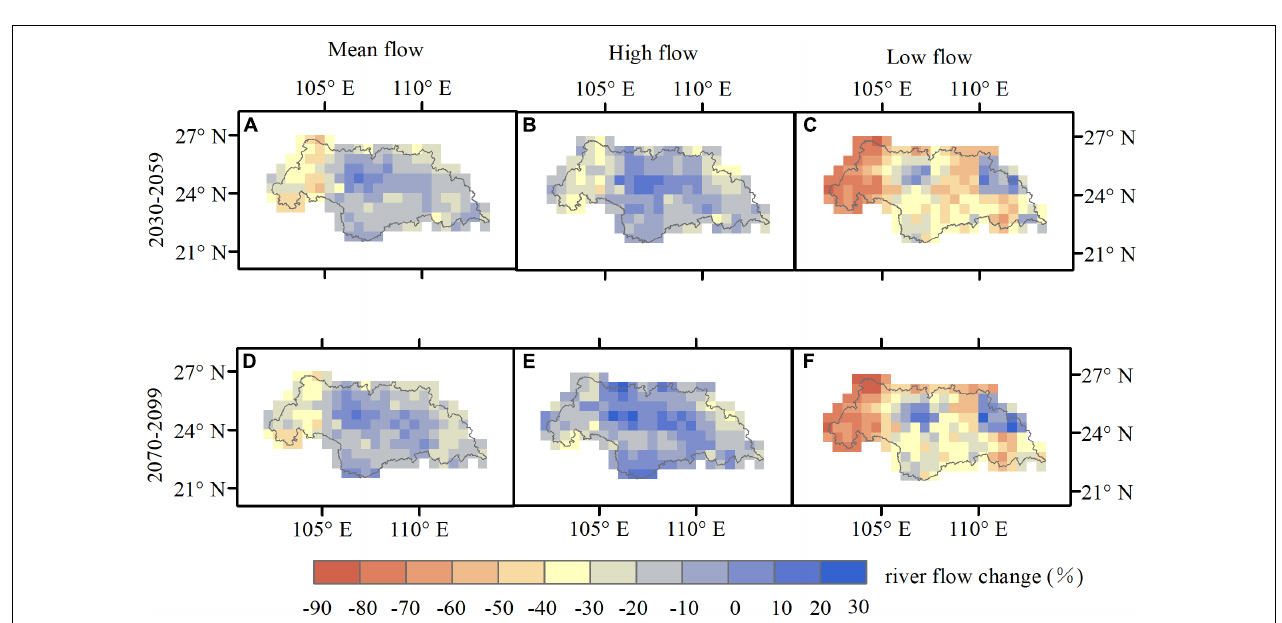
FIGURE 2 | Changes in temperature ( ◦ C) between the future periods and the historical period 1971–2000: (A) 2030–2059 and (B) 2070–2099, and changes in precipitation (%) between the future periods and the historical period 1971–2000: (C) 2030–2059 and (D) 2079–2099.